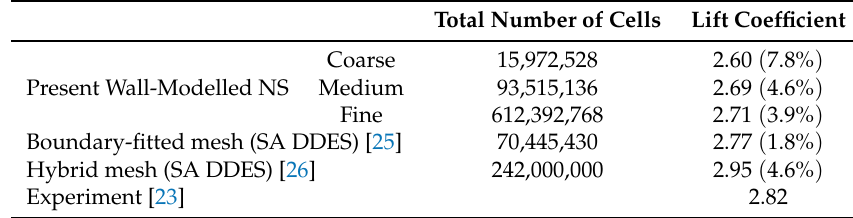
Table 4. Lift coefficient ( θ = 5.5 ◦ ) and its difference from the experiment (%); SA DDES, detached eddy simulation with Spalart–Allmaras turbulence model.